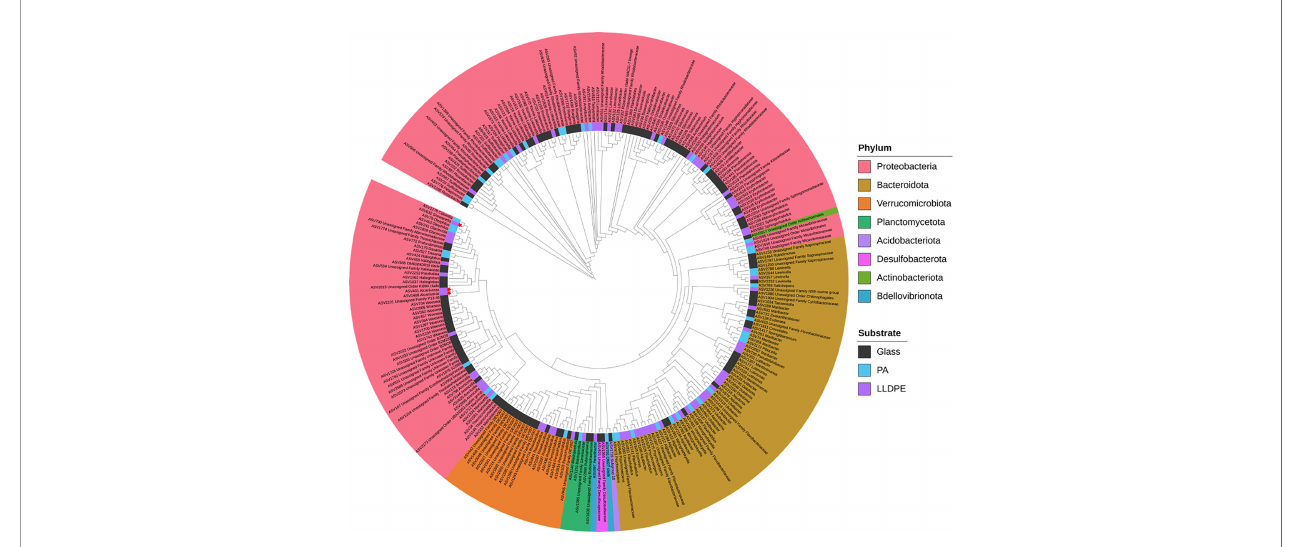
FIGURE 4 | Phylogenetic tree showing bacterial ASVs from bio fi lms in the marine environment of Te Whakaraup ō -Lyttelton Harbour, Aotearoa-New Zealand, identi fi ed as indicative of substrate type by indicator species (IndVal) analyses assessed Monte Carlo tests using 999 permutations (P < 0.05). Substrate type is shown by the colours between branches and leaves (i.e. the inner coloured ring), leaves are coloured according to their phylum and red stars represent previously reported plastic biodegraders at genus level. An interactive version of this tree is available at: